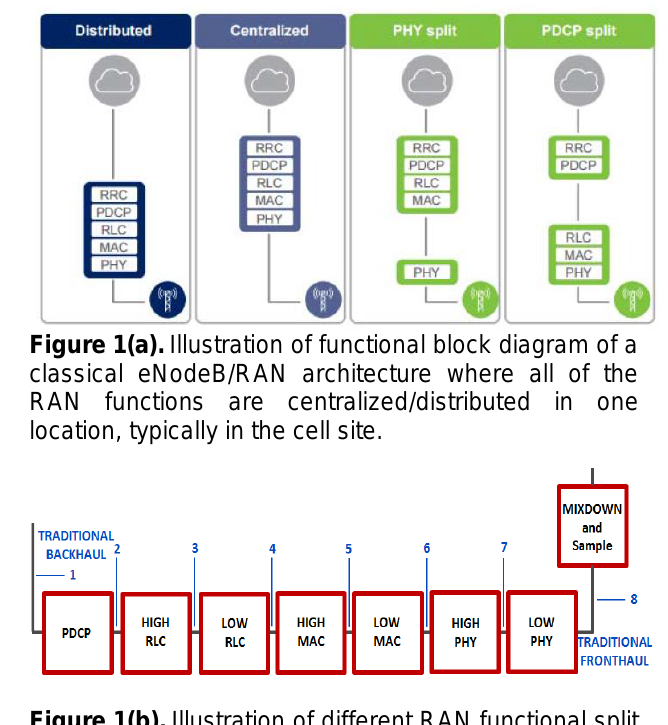
Figure 1(b). Illustration of different RAN functional split